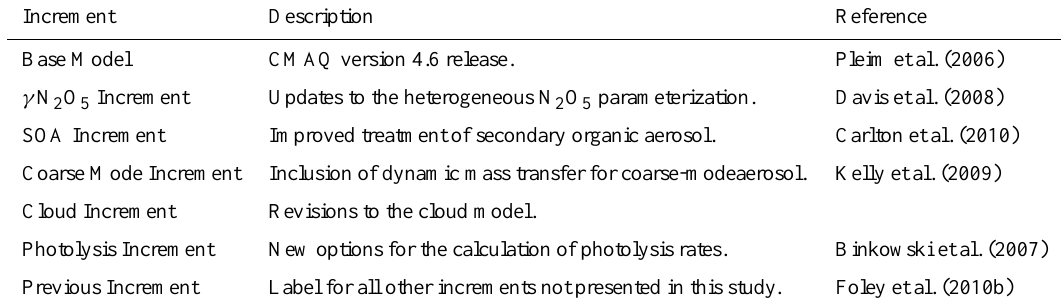
Table 1. Summary of 5 scientific and structural changes to CMAQv4.7 discussed in Sect.